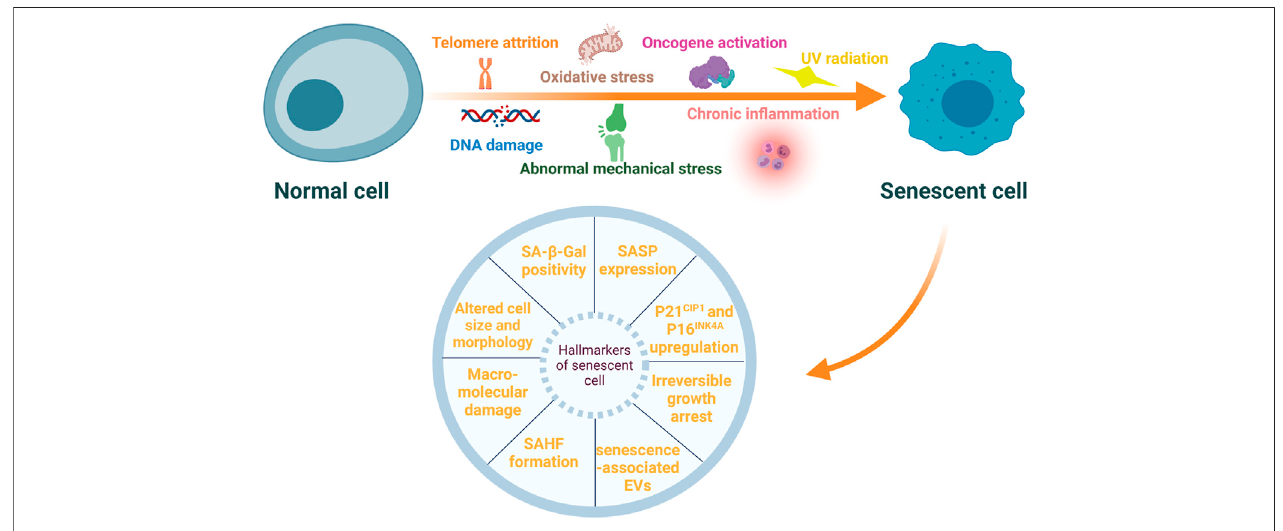
FIGURE 1 | Stressors inducing cellular senescence and hallmarkers of senescent cells. Cellular senescence can be induced by multiple internal and external stressors, such as telomere attrition, DNA damage, oxidative stress, oncogene activation, ultraviolet (UV) radiation, chronic in fl ammation, and abnormal mechanical stress. These senescent cells (SnCs) exhibit a variety of typical hallmarkers, including irreversible growth arrest, altered cell size and morphology, macromolecular damage, increased expression of p21 CIP1 and p16 INK4A , enhanced senescence-associated- β -galactosidase (SA- β -Gal) activity, senescence- associated heterochromatic foci (SAHFs) formation, senescence-associated secretory phenotype (SASP) and extracellular vesicles (EVs) associated with